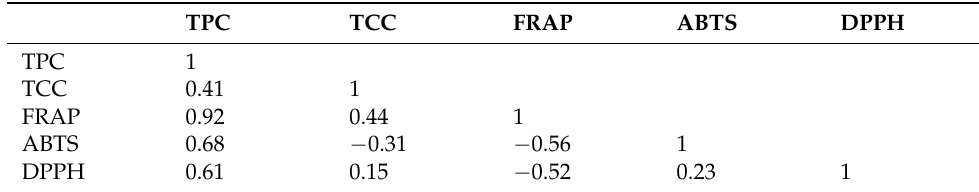
Table 4. Pearson correlation coefficients (r) of antioxidants and their activities in LAB strains fer- mented MJs from different cultivars after in vitro GI digestion.